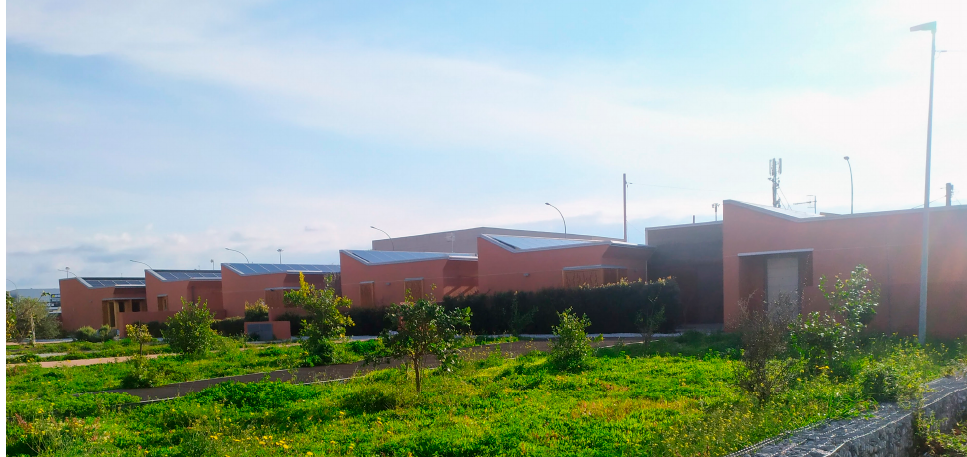
Figure 4. A view of the current status of the ecological and social housing in Fondo Saccà (2023) .